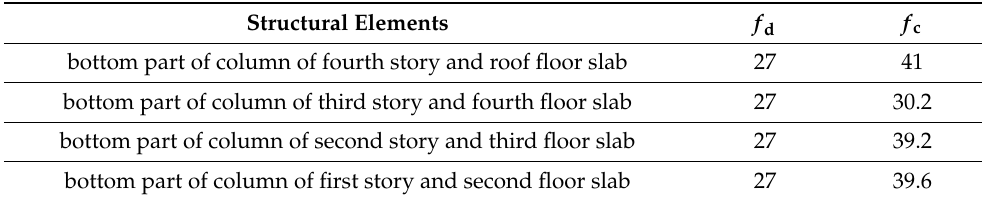
Table 4. Material properties of concrete (Unit: MPa).